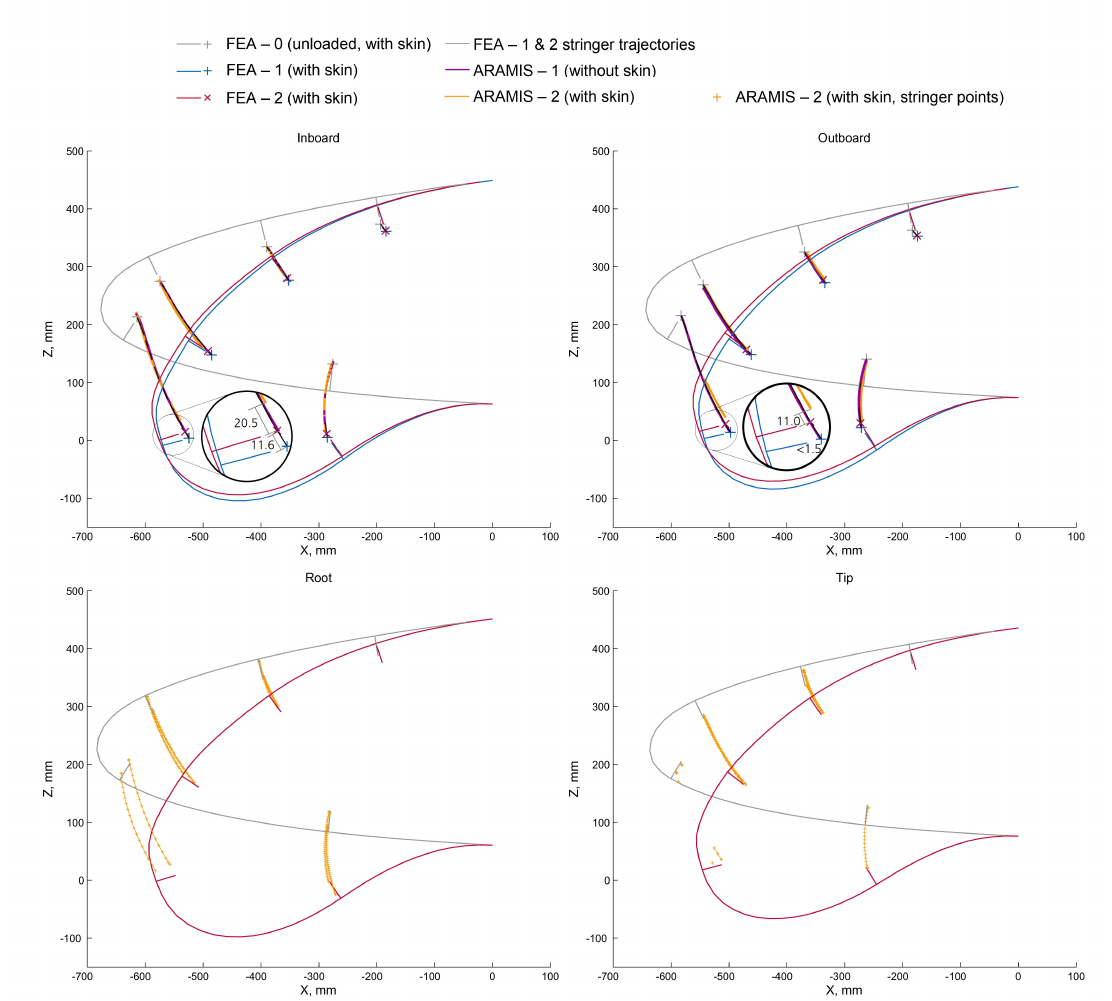
Figure 18. Postprocessed ARAMIS data sets as viewed from the XZ